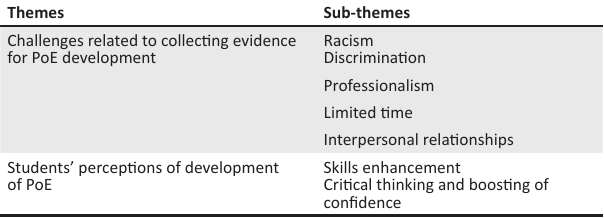
TABLE 1: Themes and sub-themes that emerged from the